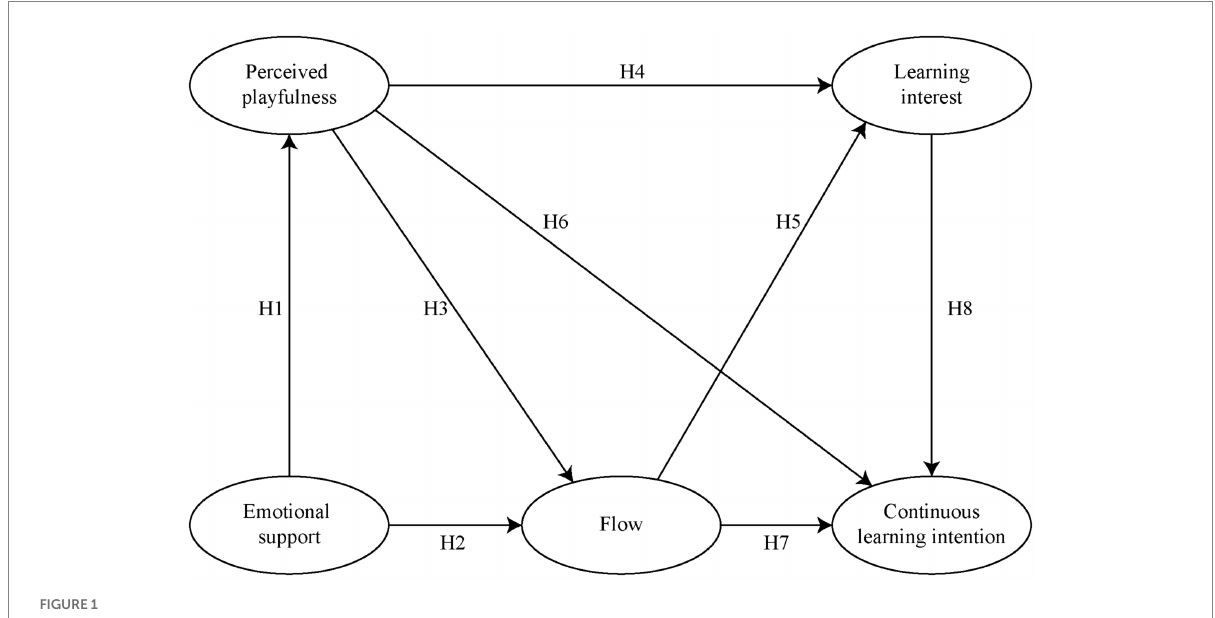
FIGURE 1 Hypotheses of the